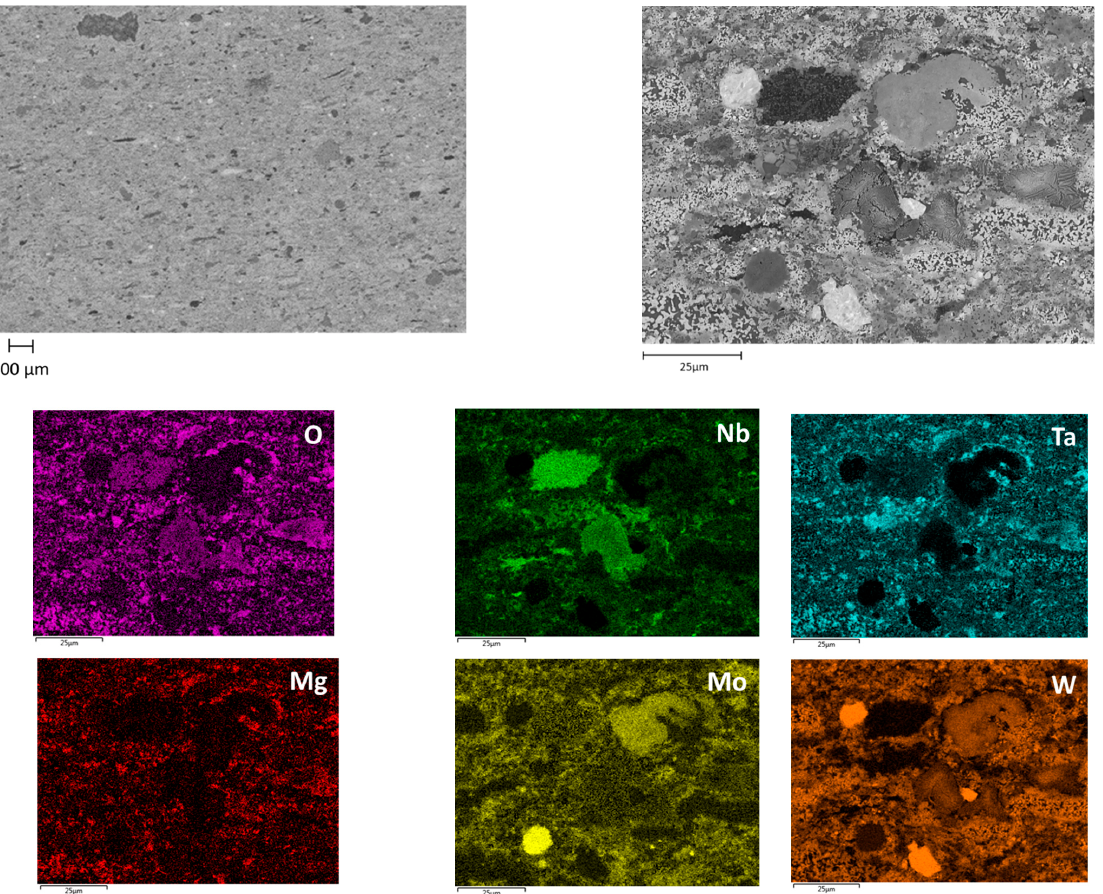
Figure 7. Chemical mapping of the sintered sample at 1600 °C under axial compression of 35 MPa for 10 min.